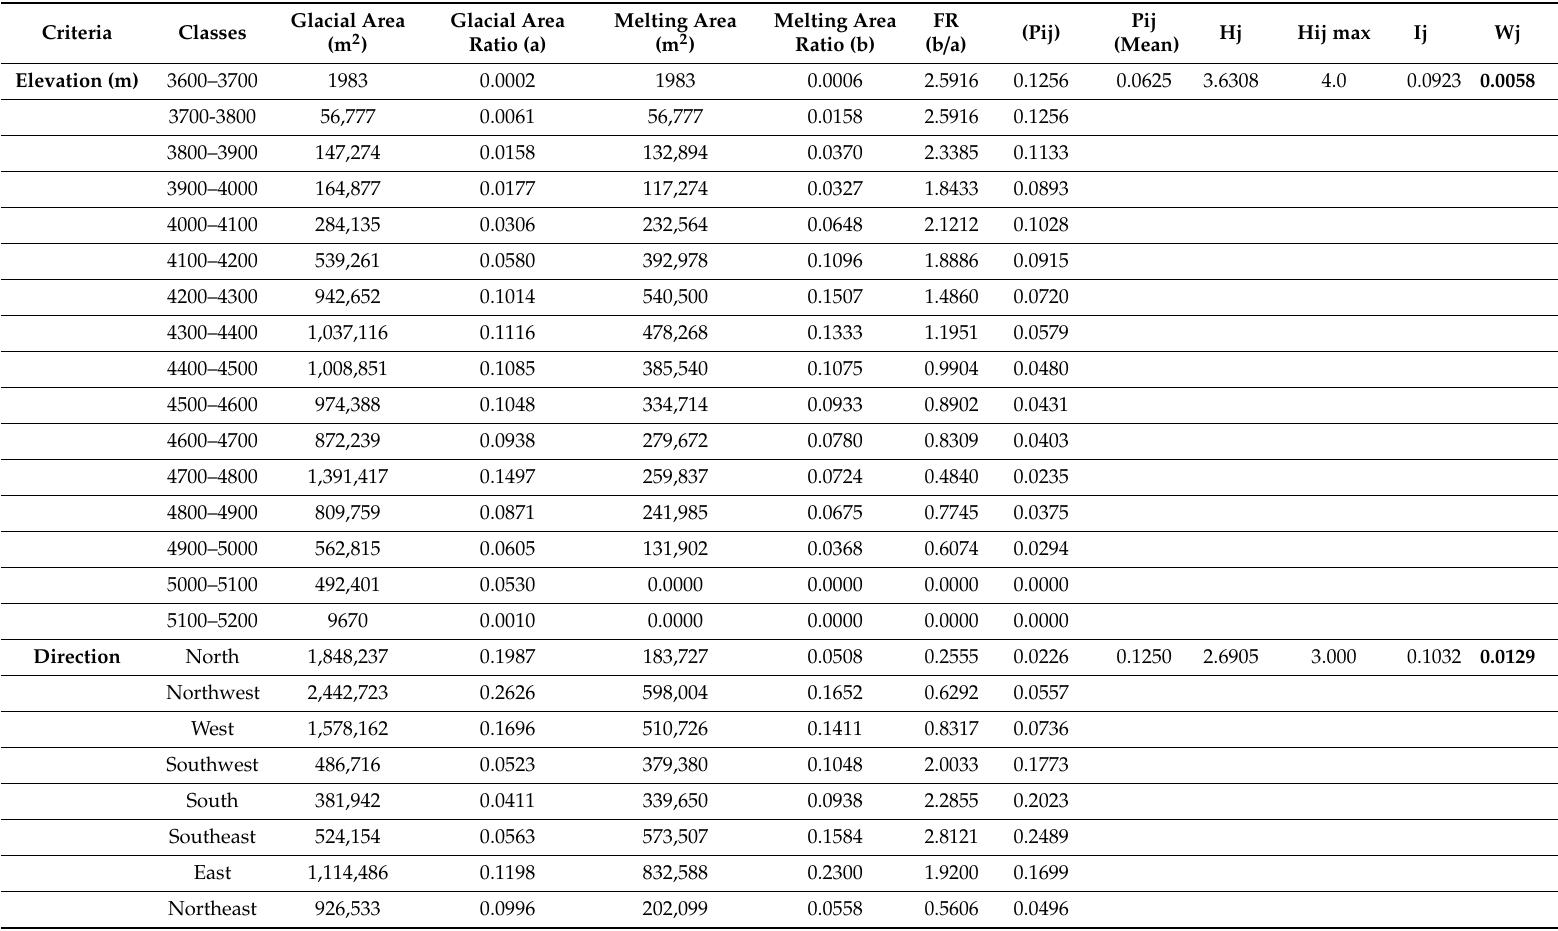
Table 1. The process of weight